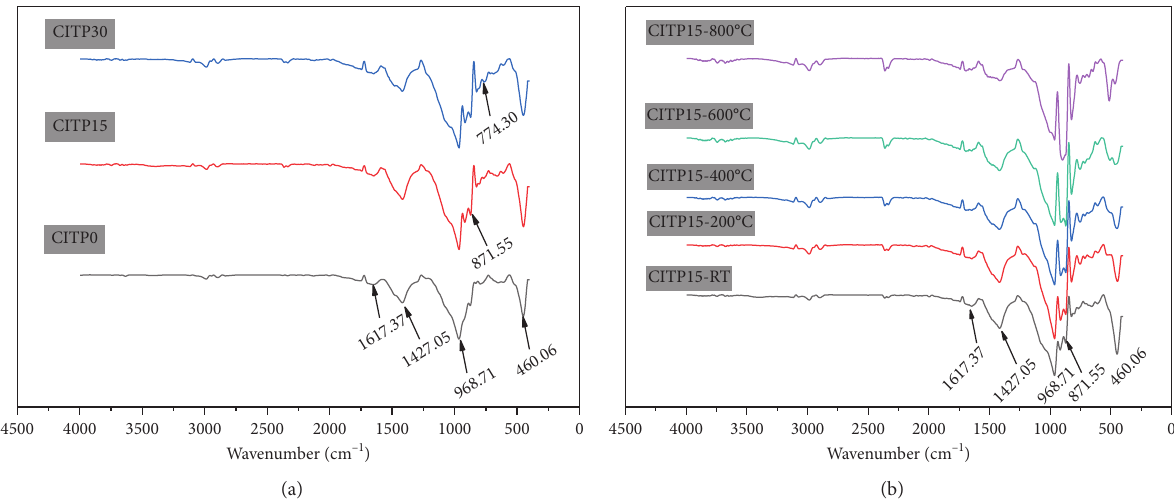
Figure 7: FTIR spectrum of concrete: (a) the reference sample CITP0, CITP15, and CITP30 at RT; (b) the sample CITP15 after exposure to high temperatures.